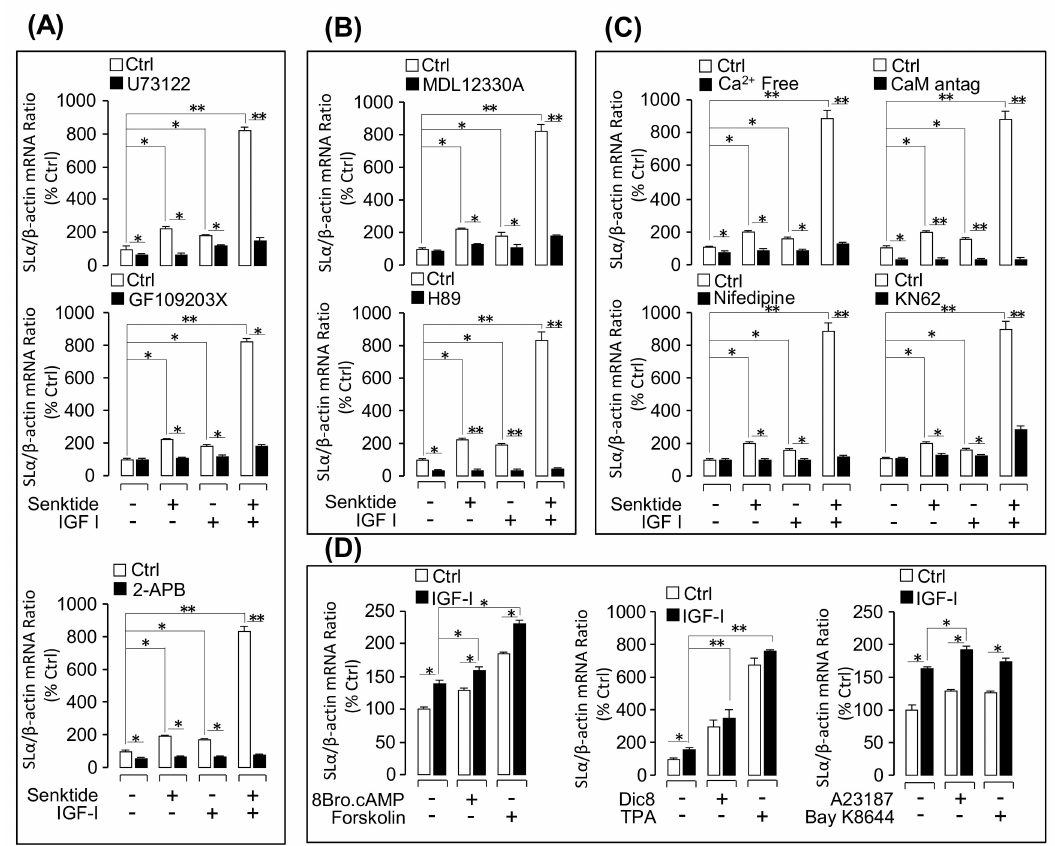
Figure 5. Signal pathways of IGF-I potentiation of senktide-induced SL α mRNA expression: ( A ) Functional role of phospholipase C (PLC)-dependent pathway in the collaborative e ff ect of senktide and IGF-I. In this experiment, U73122 (10 µ M), GF109203X (10 µ M), or 2-APB (100 µ M) were used to block senktide (1 µ M), IGF-I (100 nM), and senktide (1 µ M) + IGF-I (100 nM)-induced SL α mRNA expression in grass carp pituitary cells. ( B ) MDL12330A (10 µ M) or H89 (10 µ M) were used to block senktide (1 µ M), IGF-I (100 nM), and senktide (1 µ M) + IGF-I (100 nM)-induced SL α mRNA expression. ( C ) Ca 2 + -free medium, Nifedipine (10 µ M), calmidazolium (1 µ M), or CaMK-II inactivator KN62 (10 µ M) were used to examine the Ca 2 + pathway involved in senktide (1 µ M), IGF-I (100 nM), and senktide (1 µ M) + IGF-I (100 nM)-induced SL α mRNA expression. ( D ) The synergistic e ff ects of IGF-I (100 nM) with 8Br.cAMP (10 µ M), forskolin (1 µ M), Dic8 (100 µ M), TPA (10 µ M), A23187 (100 nM), or BayK8644 (100 nM) on SL α mRNA expression are shown. The asterisk was used to reveal the significant di ff erence between two groups (“*” means P < 0.05, and “**” means P <